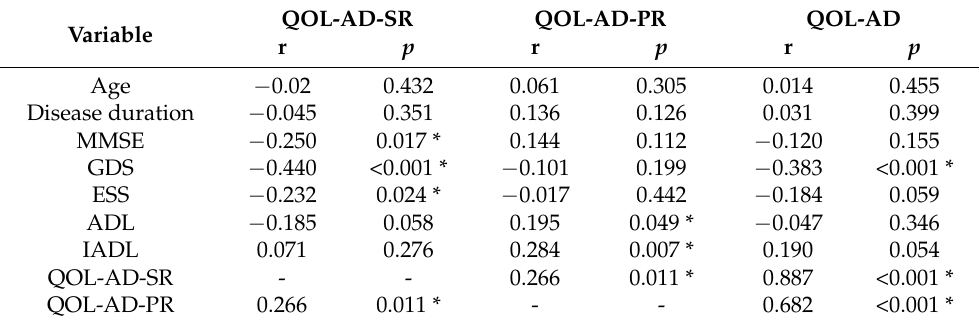
Table 2. Correlations of quality of life in Alzheimer’s disease, quality of life in Alzheimer’s disease— self-rated and quality of life in Alzheimer’s disease—proxy-rated with study variables.